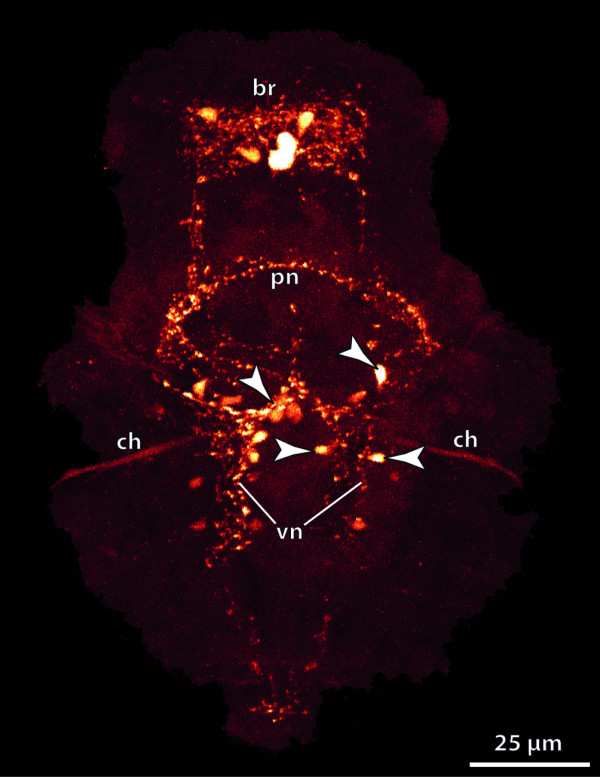
Nervous system of the trochophore larva of the polychaete annelid Filograna implexa. The prototroch neurite, the anlage of the brain, the chaetae, the paired ventral neurite bundle, and the associated somata (arrowheads) are stained. [Serotonin-like immunoreactivity.] Abbreviations: br = brain; ch = chaetae; pn = prototrochal neurite; vn = ventral neurite bundle. Original: A. Wanninger.